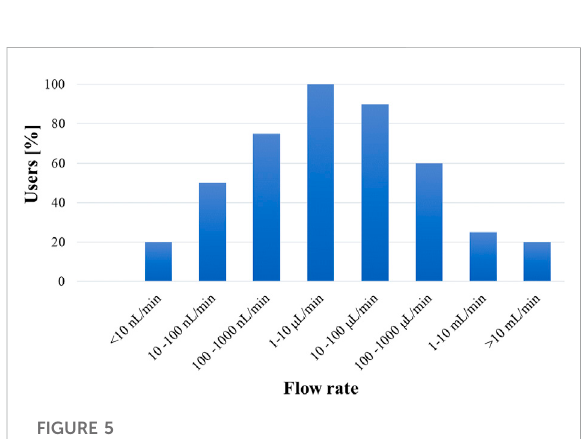
FIGURE 5 Typical fl ow rates used in micro fl uidic devices based on industry feedback (The Micro fl uidics Association,